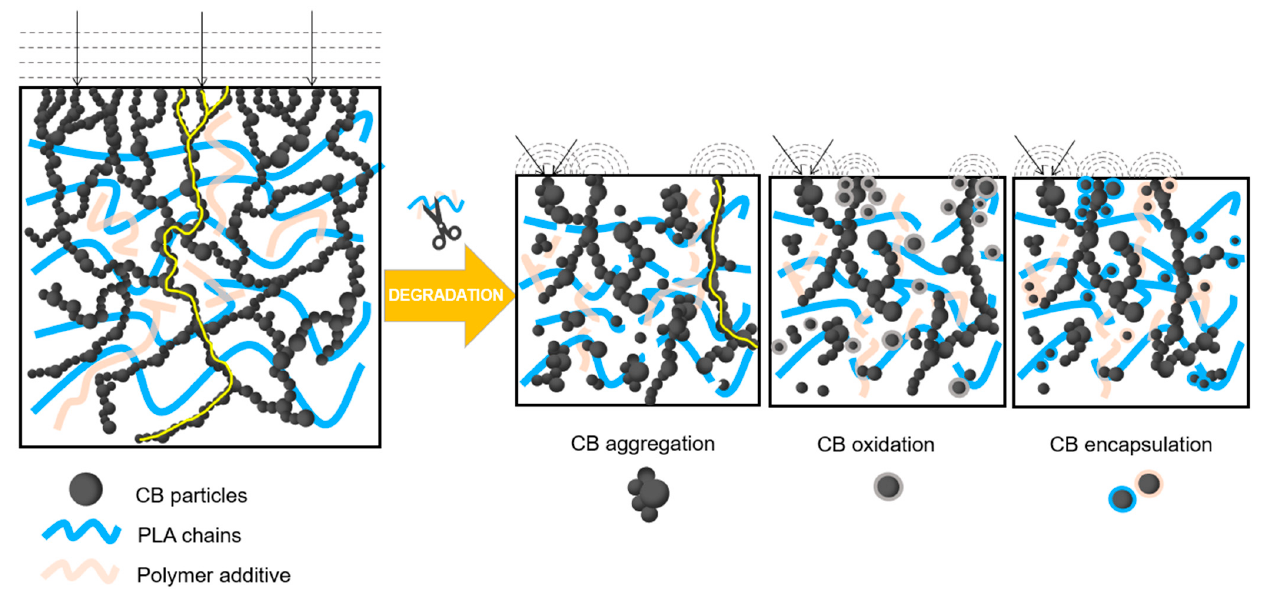
Figure 9. Schematic degradation mechanism of multiple reprocessed CB–PLA .